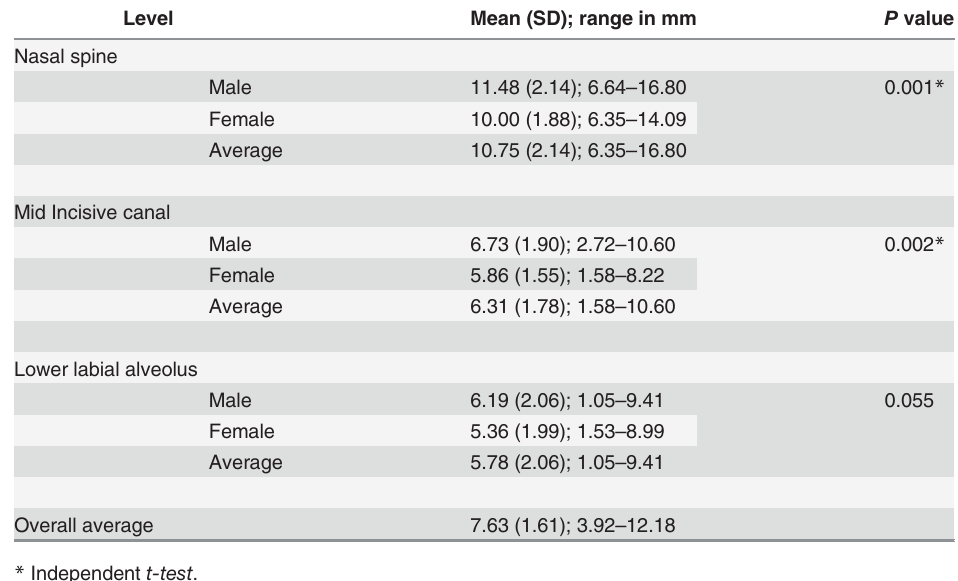
Table 4. Anterior maxillary bone